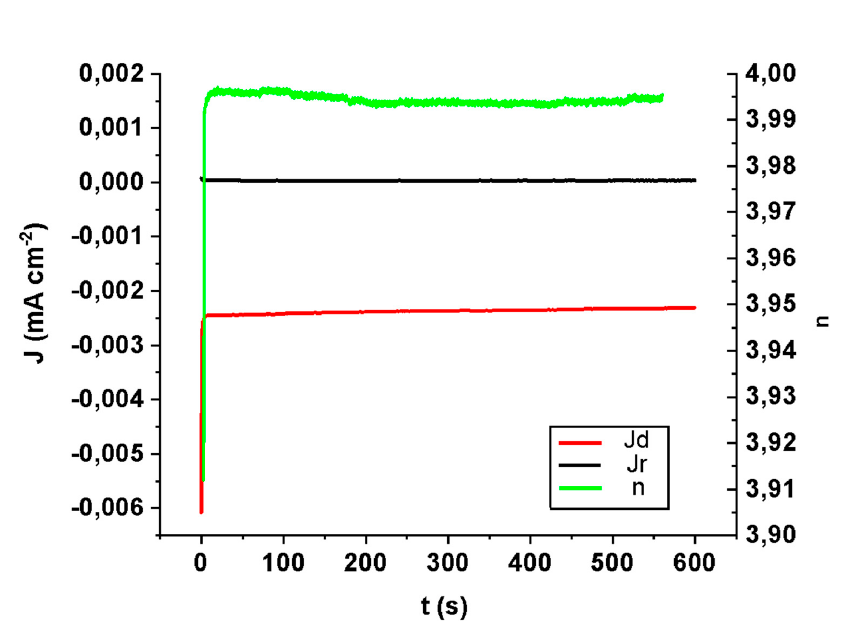
Figure 2. Volcano curves as obtained by plotting: ( a ) the potential values at j = − 0.5 mA·cm − 2 ; and ( b ) onset potential values versus time of Co electrochemical deposition.